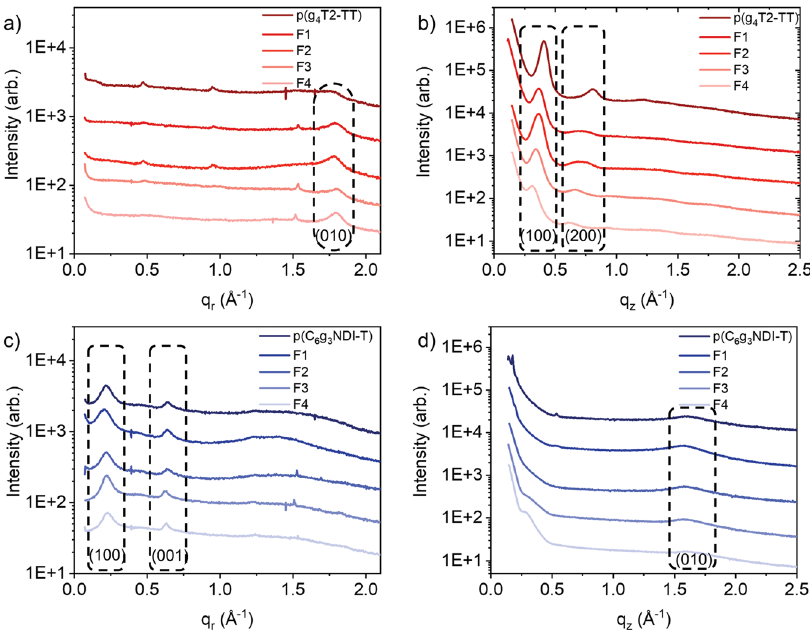
Fig.2|Two-dimensionalgrazingincidencewideangleX-rayscattering. GIWAXS line cuts of as-cast thin fi lms of the unpuri fi ed and four fractions of the two poly- mers. showing a in-plane ( q r ) and b out-of-plane ( q z ) line cuts of each fraction of